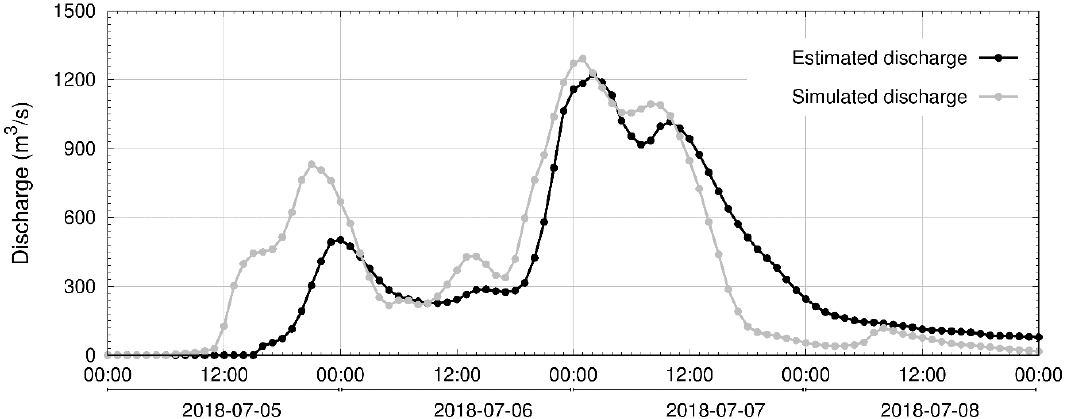
Figure 6. A time series profile of the discharge at the Yakage station in the Oda river basin.